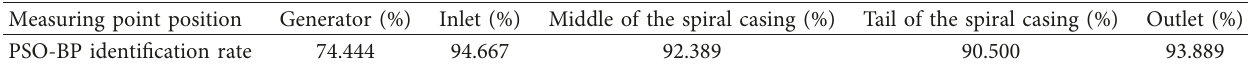
Table 5: Identification rates of three units based on PSO-BP neural network. Measuring point